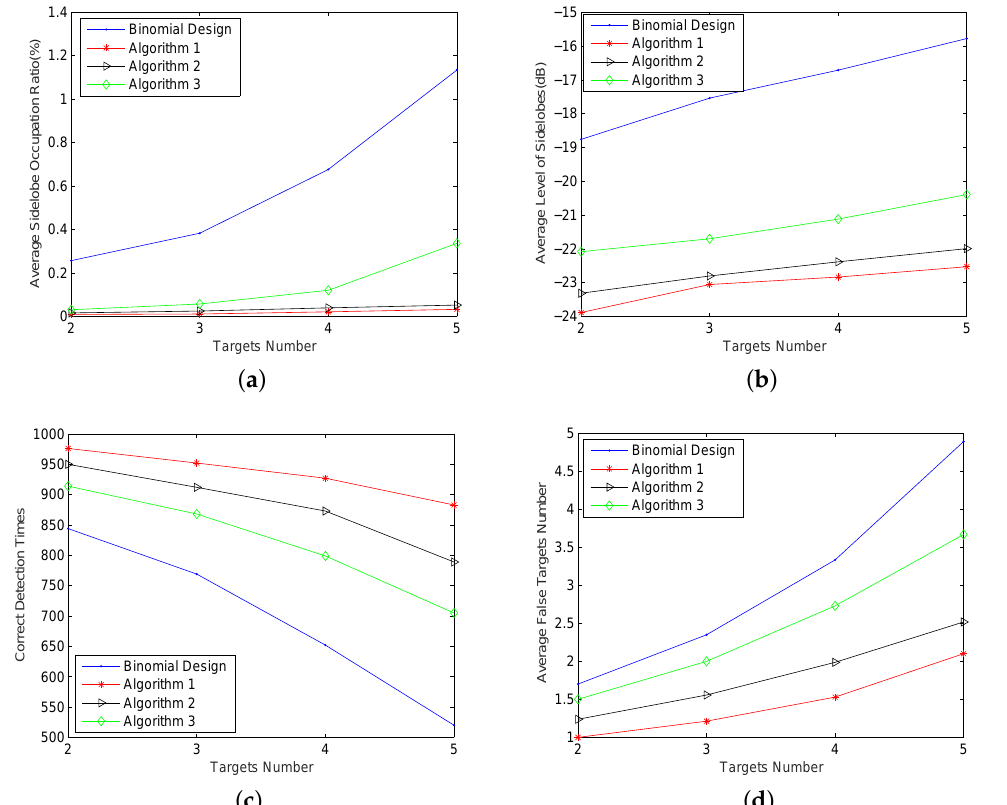
Figure 10. Statistical simulation results of ( a ) average false-alarm sidelobes occupation ratio in the Delay–Doppler map; ( b ) average energy level of false-alarm sidelobes; ( c ) correct detection times; ( d ) average false targets number for the four